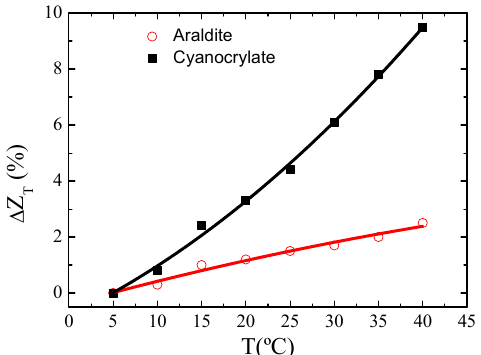
Figure 7. Functional dependence of the relative variation of impedance, Z T ( T ) , with temperature, T.